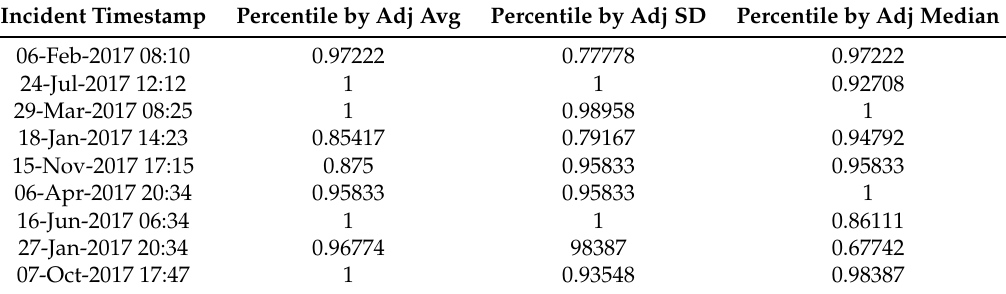
Table 13. Percentiles of Phase 2-Train incidents when sorted by sensor, day of year, and time of day based on their adjacency statistics.